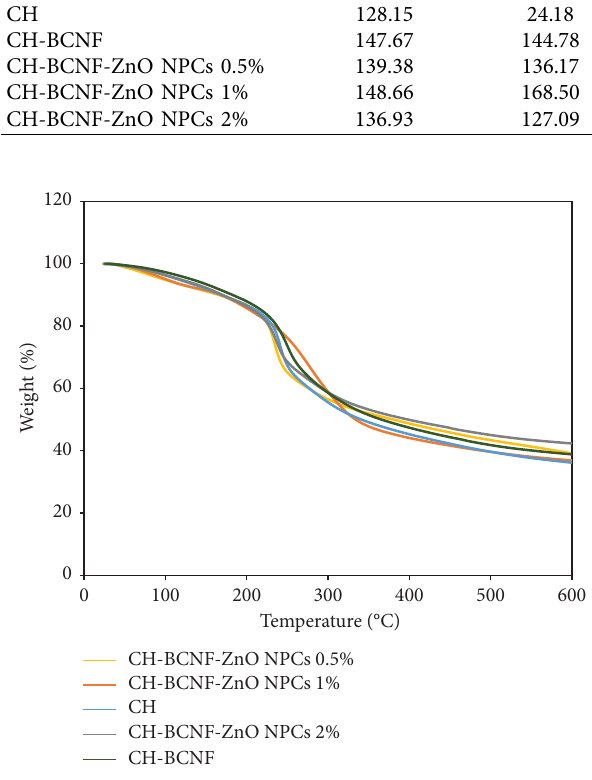
Figure 2: TGA thermograms of diferent